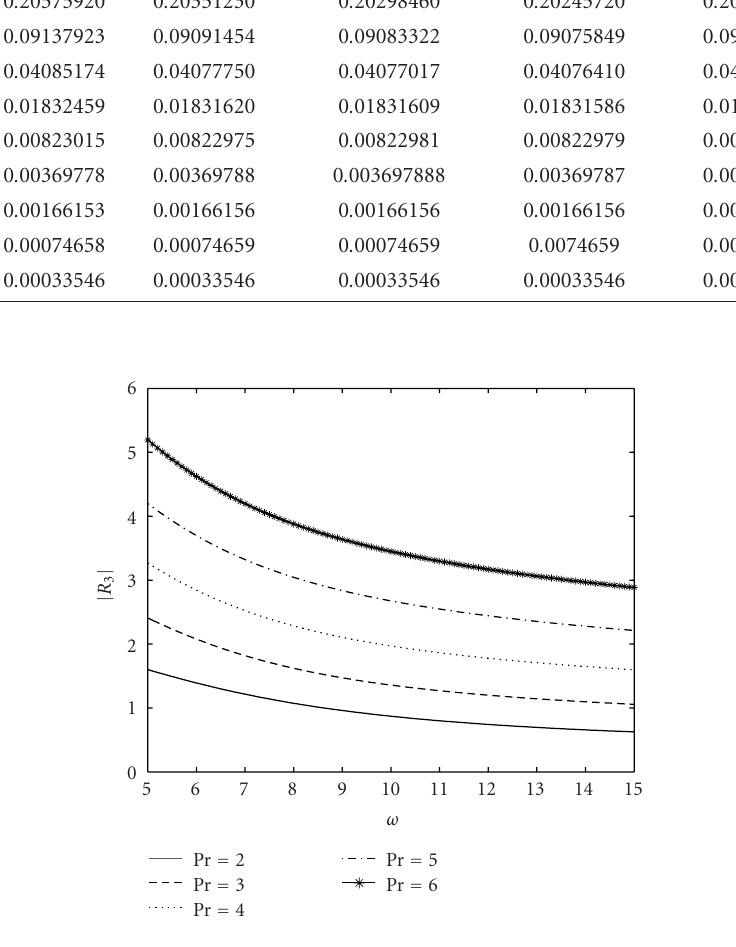
Figure 4.11. Amplitude of the rate of heat transfer for Gr = 5 . 0, S = 1 .